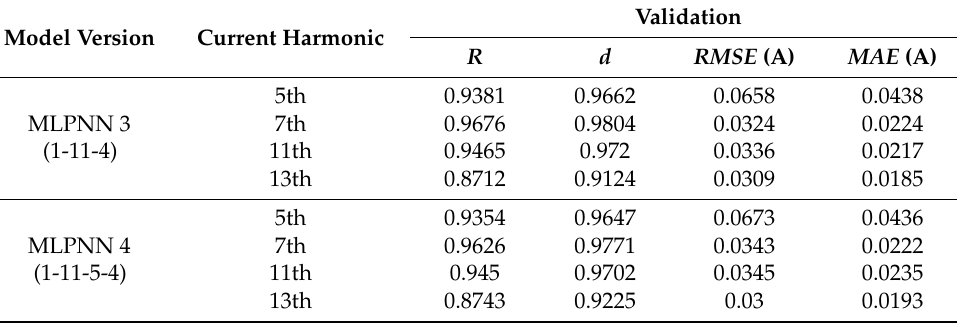
Table 6. Performance of the MLPNN with two input variables ( G and T amb ).